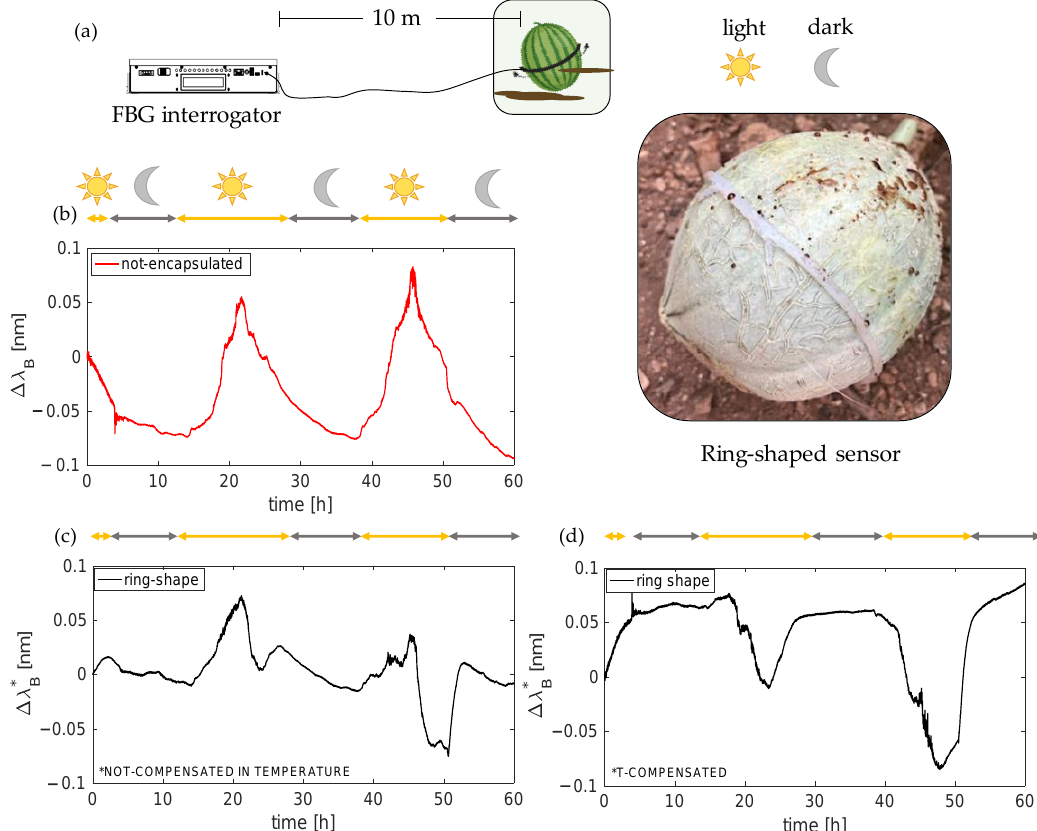
Figure 10. The setup used for in-field tests including the FBG interrogator with a picture of the ring-shaped sensor around the fruit ( a ); the non-encapsulated FBG sensor output changes over time ( b ); the ring-shaped sensor output changes before ( c ) and after T compensation ( d ).